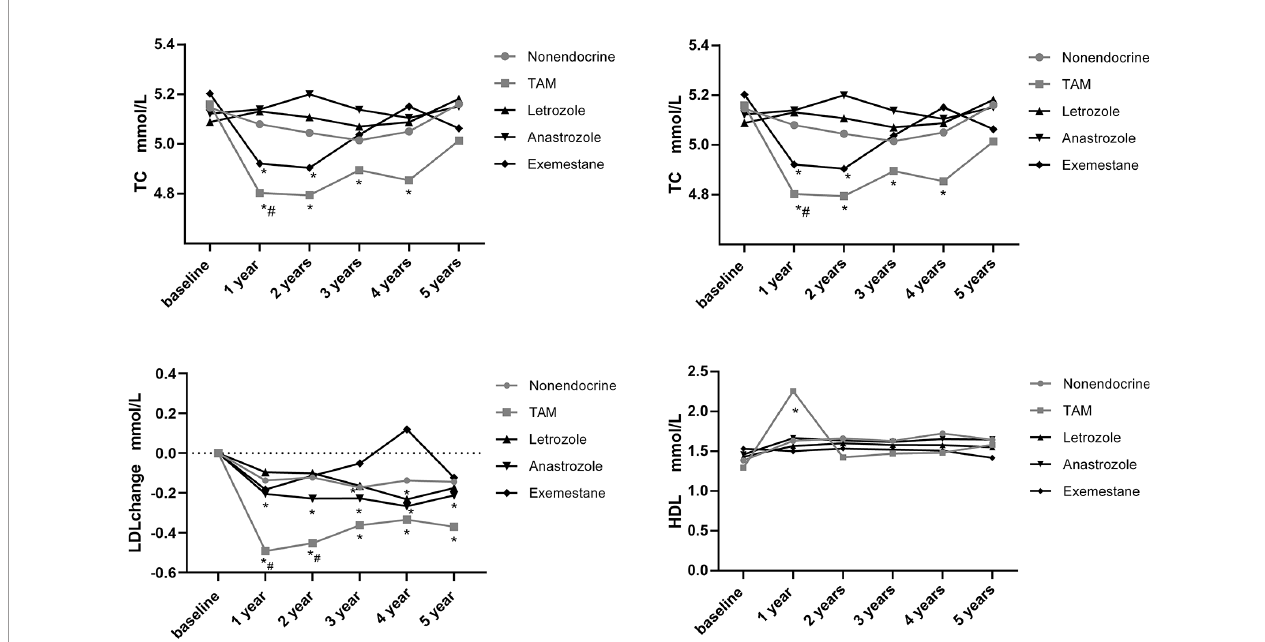
FIGURE 4 | Line chart of lipid pro fi les during 5-years endocrine therapy in postmenopausal BC patients. *p < 0.05 for comparison with baseline. # p < 0.05 for comparison with the nonendocrine